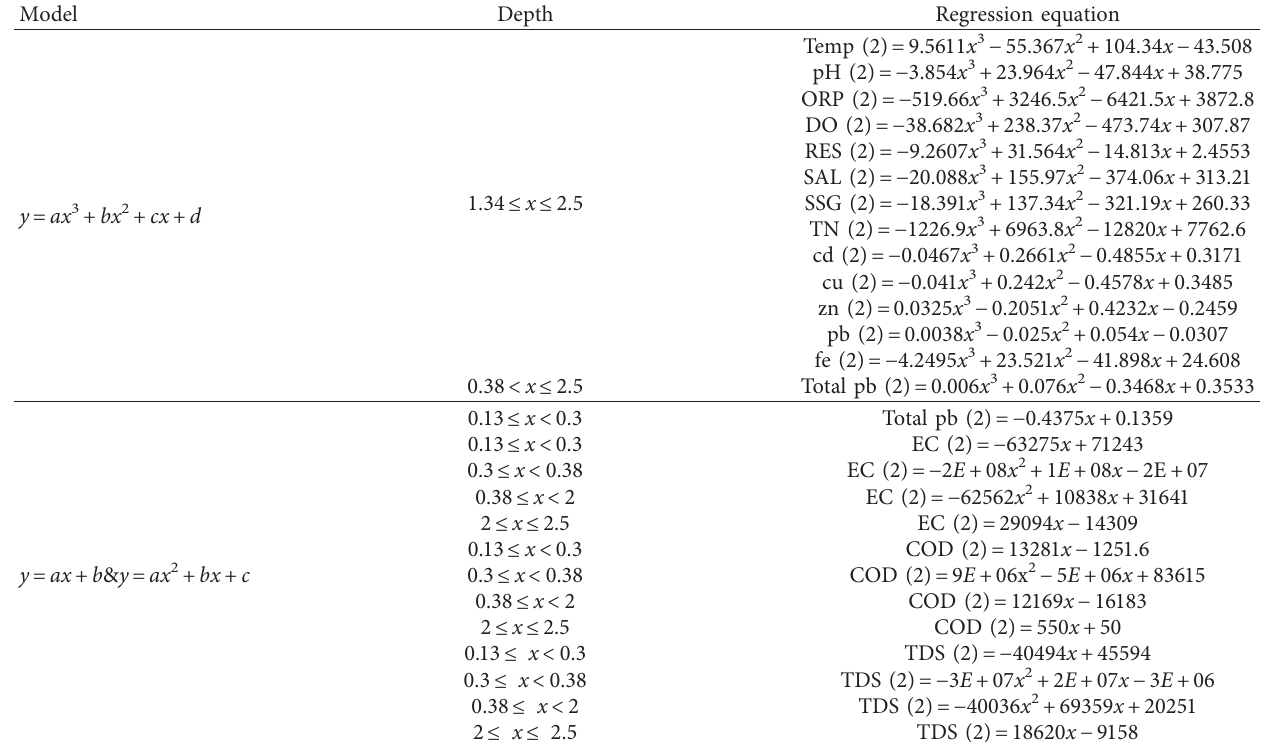
Table 3: Regression models polynomial of the first, second, and third